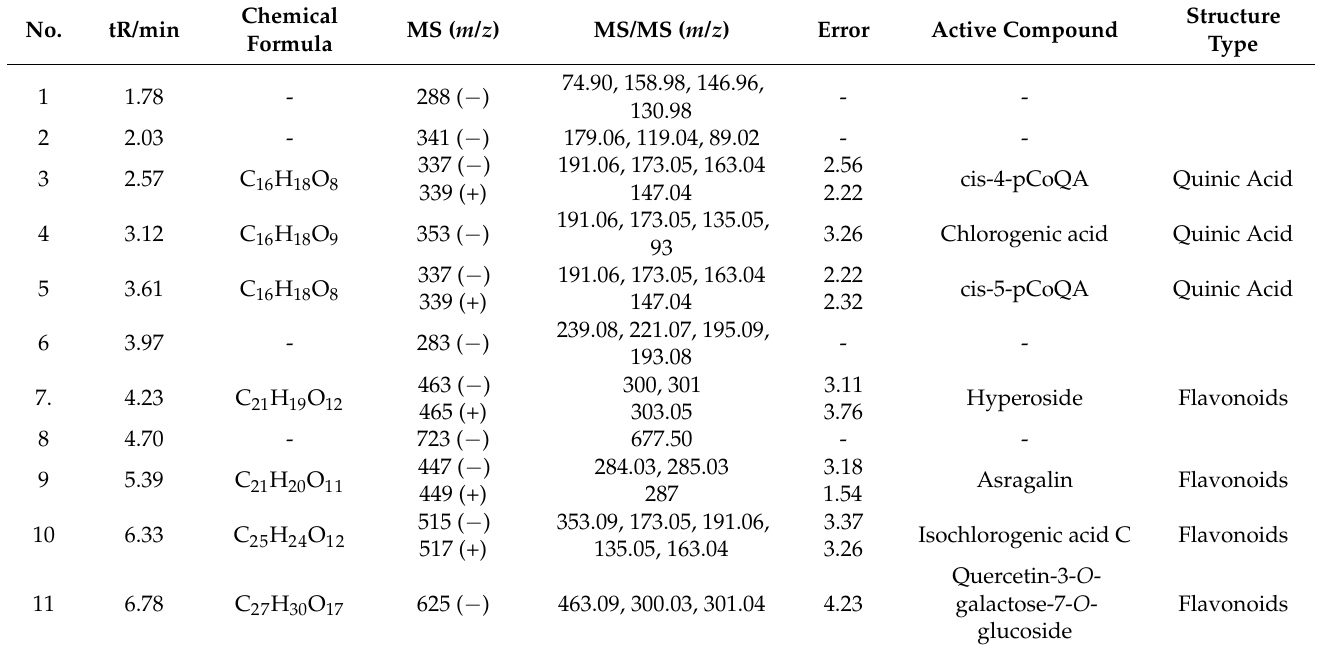
Table 3. LC/MS data of TSZE-EA-G6 fraction.